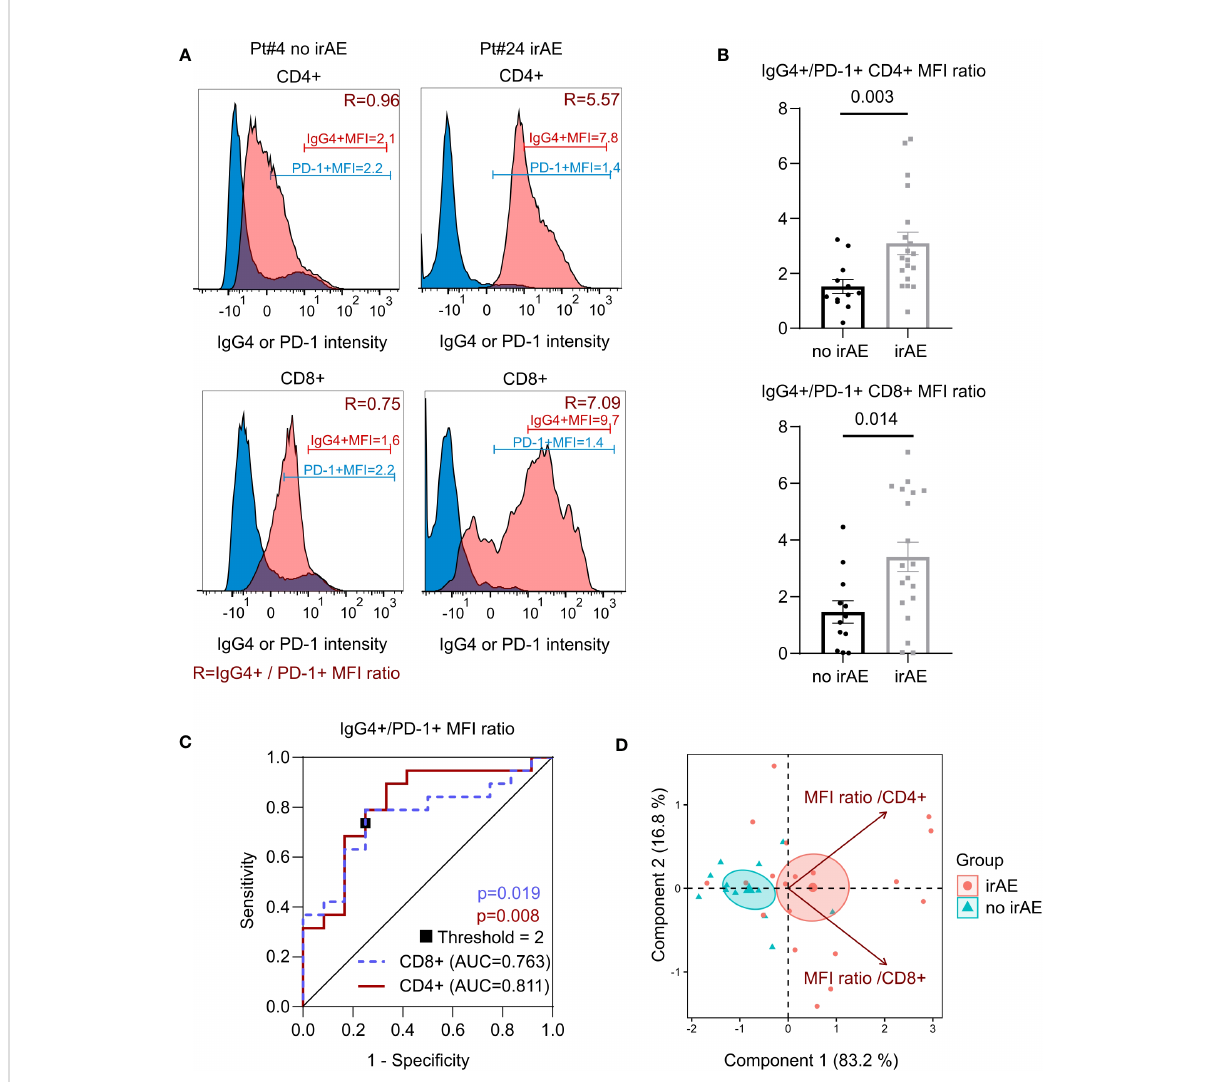
FIGURE 2 Comparison of therapeutic antibody binding during ICI (Immune checkpoint inhibitors) related toxicity (irAE). (A) Representative example of fl ow cytometry analysis of cells from blood of two patients with (Pt#24, myocarditis) or without side effect (Pt#4) post ICI (both). Histograms of IgG4 and PD-1 levels in CD4+ and CD8+ T cells. IgG4+ MFI, PD-1+ MFI and MFI ratio (shown in dark red, R). (B) Ratio of mean fl uorescence intensity (mean ± SEM) of IgG4+ and PD-1+ in CD4+CD3+ cells and CD8+CD3+ cells of patients treated by ICI developing (n=18) or not irAEs